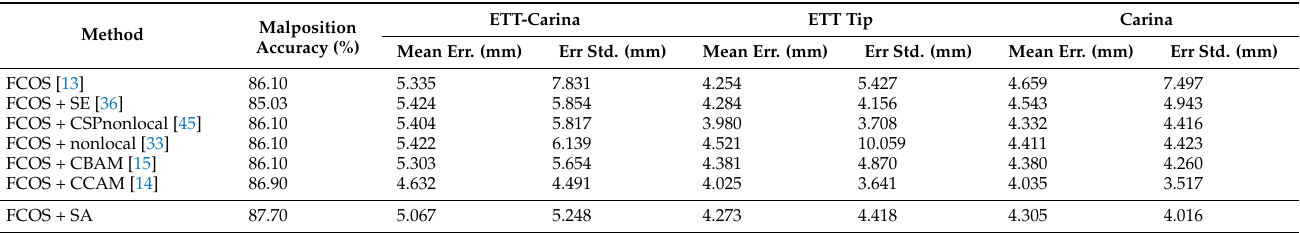
Table 17. The comparison results of attention